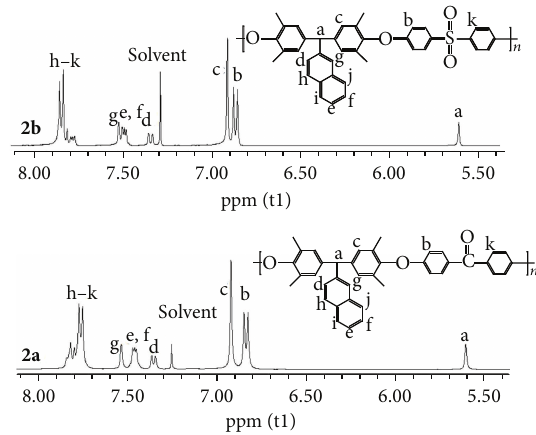
Figure 2: 1 H NMR spectrum of polymers 2 in CDCl 3 .